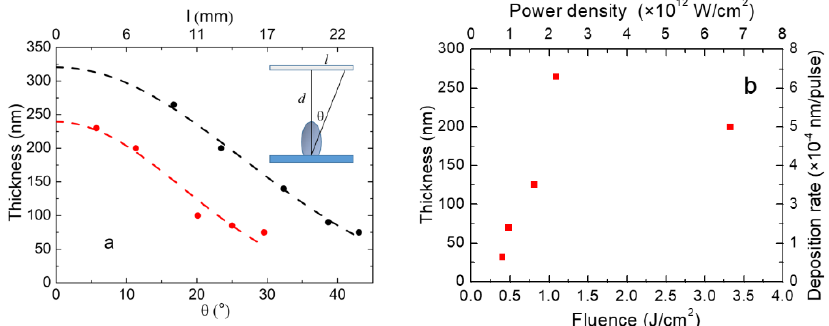
Figure 2. Thickness ( Th ) of the deposited boron films grown at room temperature as a function of the ( a ) θ angle from the ablation plume axis for the samples deposited at 1.1 (black dots) and 3.3 J/cm 2 (red dots) and ( b ) the fluence at l = 7 mm (red squares).